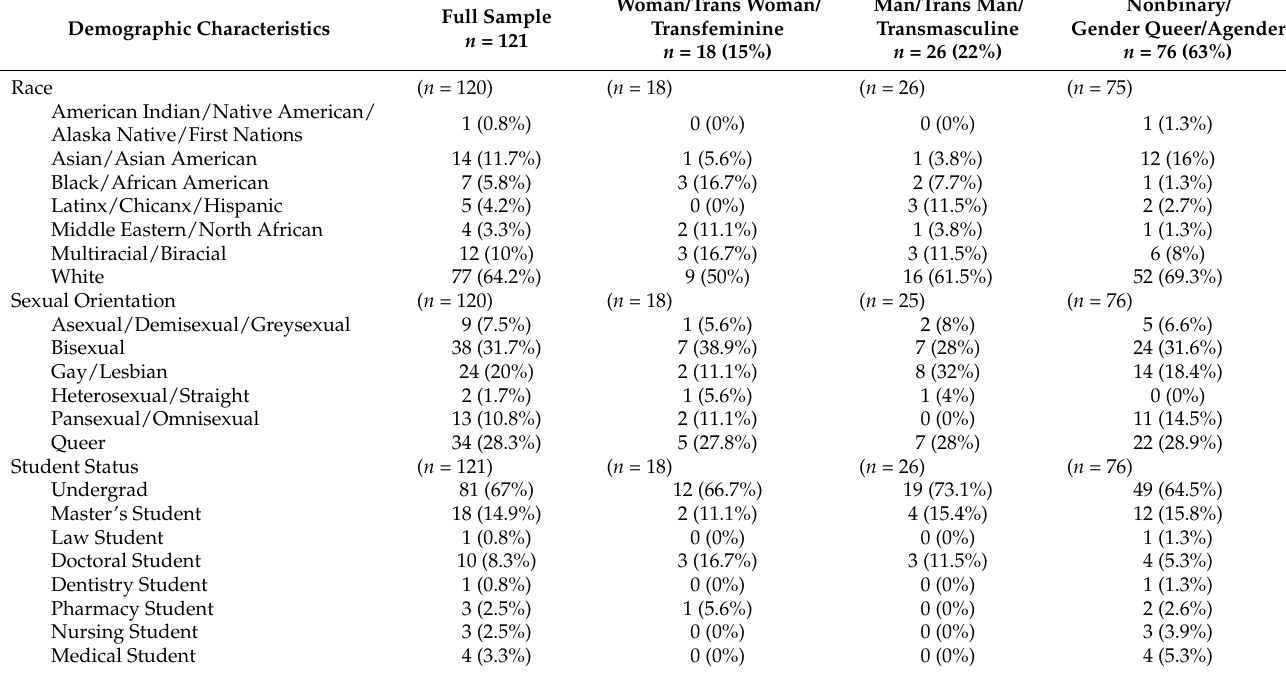
Table 1. Participant demographics among full sample and different gender identities 1